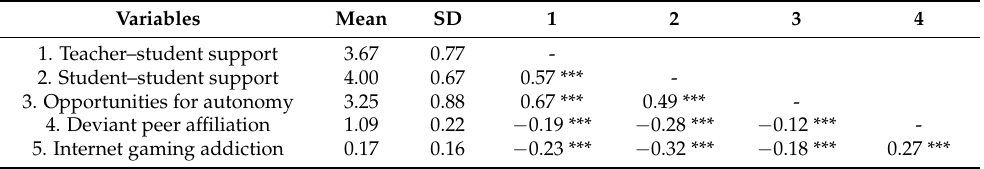
Table 1. Means, standard deviation, and bivariate correlations between perceptions of school climate, deviant peer affiliation, and adolescent IGA ( N =